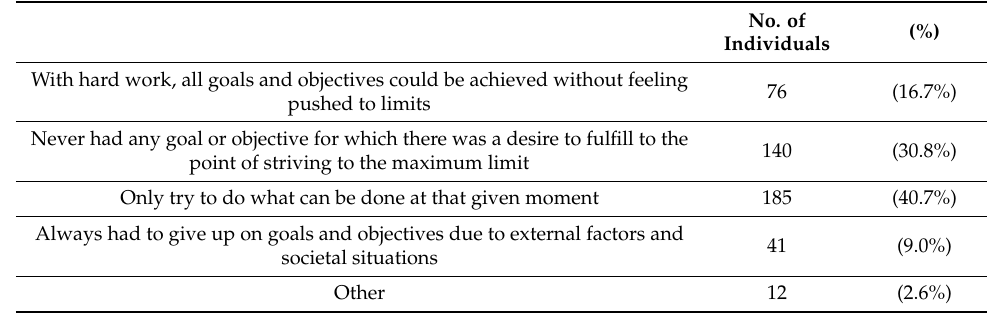
Table 3. Reasons for not having LE or